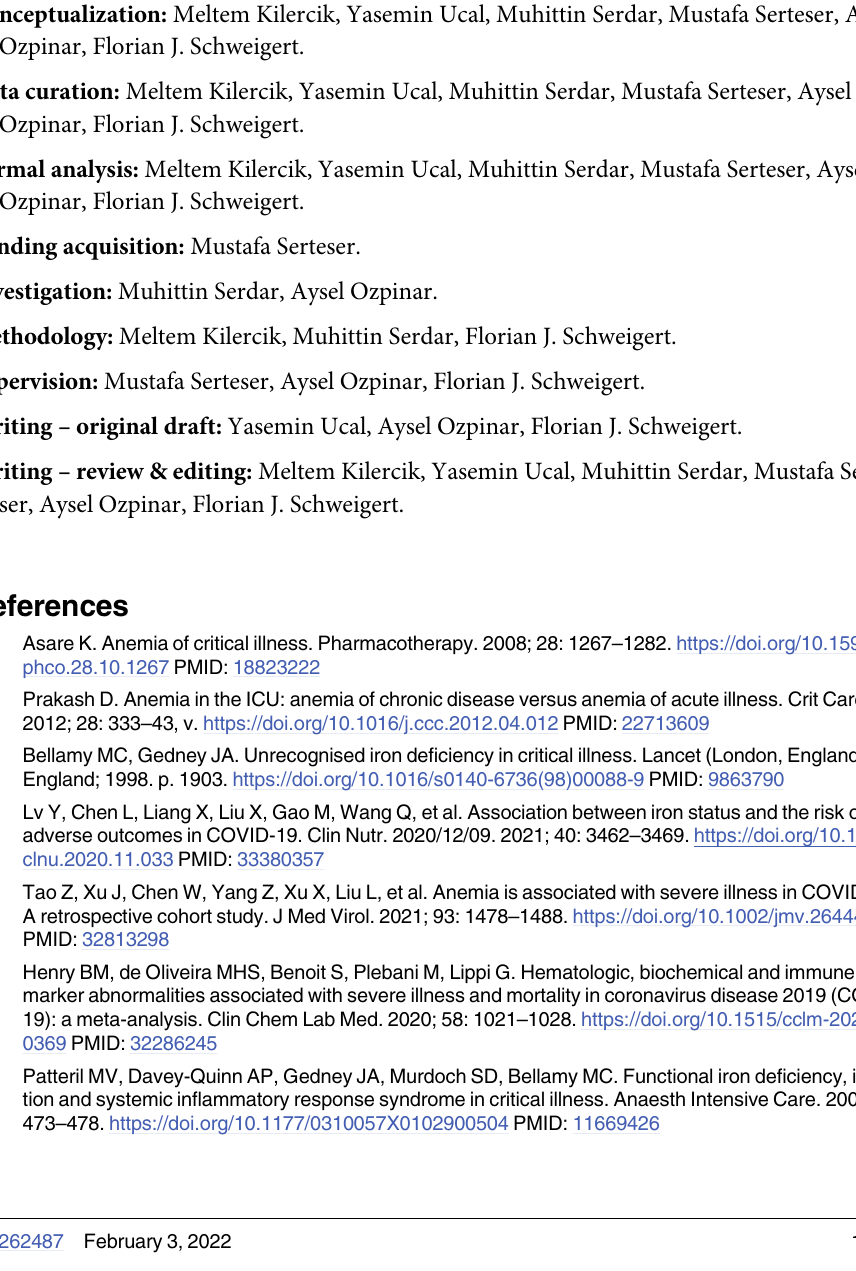
S1 Table Measurement methods and analyzers for the analytes measured as part of CBC and other hematological analyses. S2 Table Receiver operating characteristic (ROC) curve analysis for specific